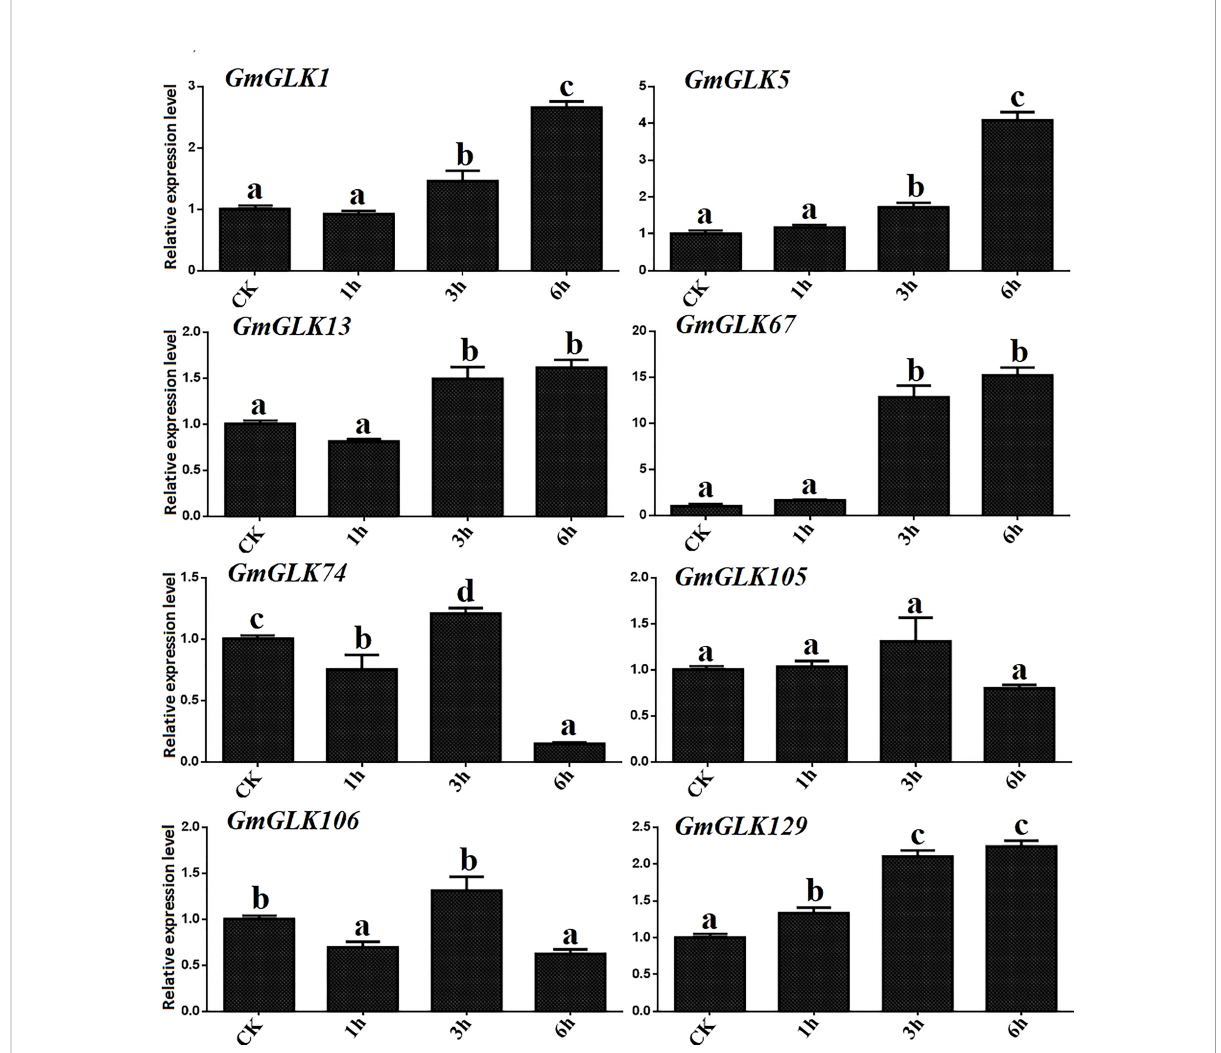
FIGURE 7 qRT-PCR analysis of the relative expression of GLK members in soybean under Cu stress. The time in hours is represented through the x-axis, and the relative expression level through y-axis. Tukey ’ s HSD tests were utilized to measure the differences among effects on various time frames for Cu exposure. The alphabetical letters indicate signi fi cant difference